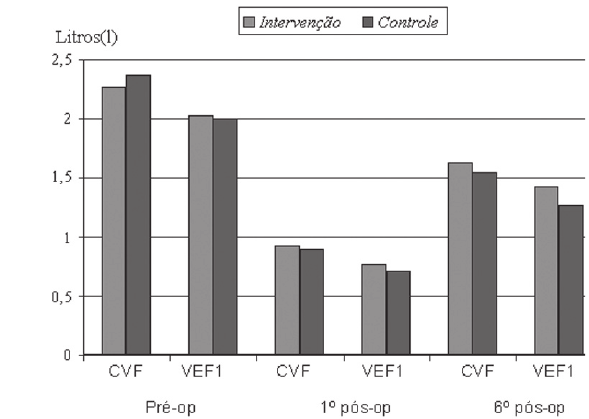
Fig. 3 - Capacidade vital forçada (CVF) e Volume expiratório forçado no 1º segundo (VEF1) no pré, 1º e 6º pós-operatório. CVF = capacidade vital forçada; VEF1 = volume expiratório forçado